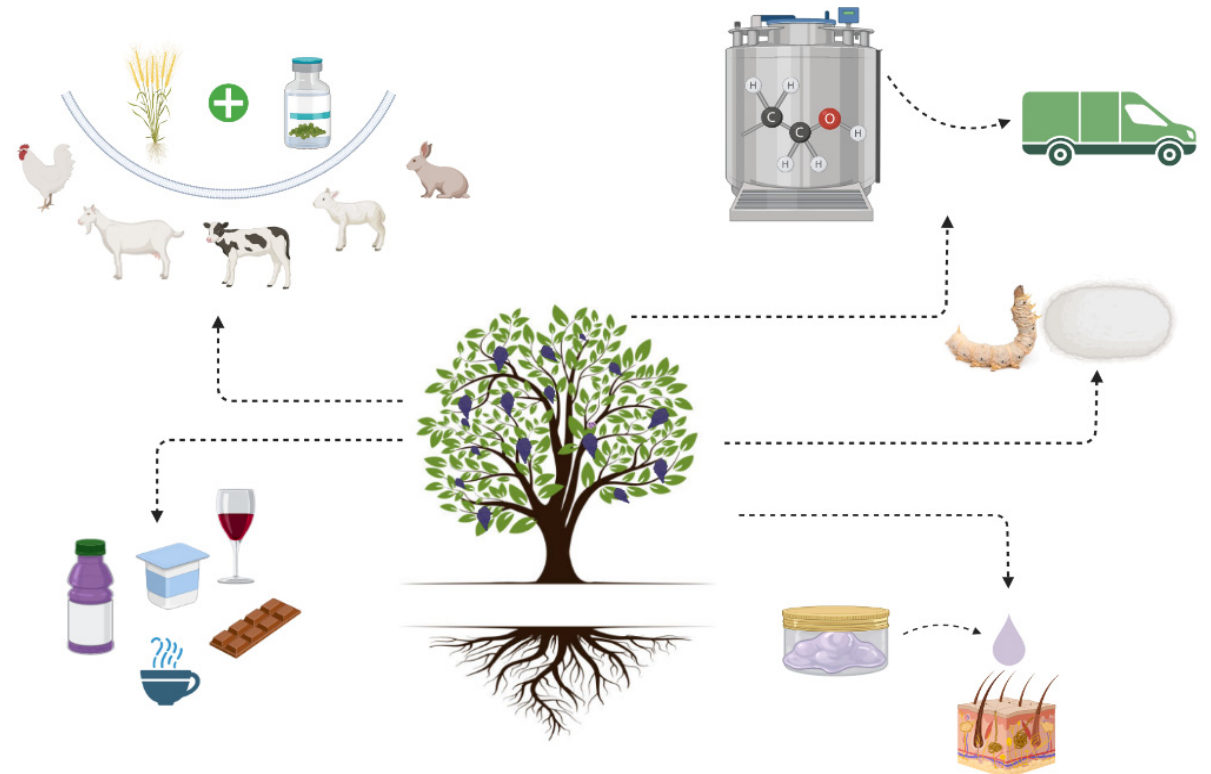
Figure 2. Main applications of mulberry in various industries (created with BioRender.com, accessed on 10 February